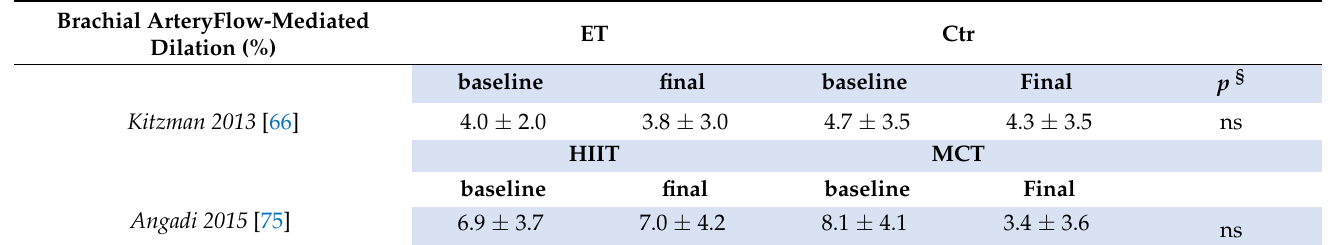
Table 6. Results of trials investigating the effects on brachial artery flow-mediated dilation of exercise training in